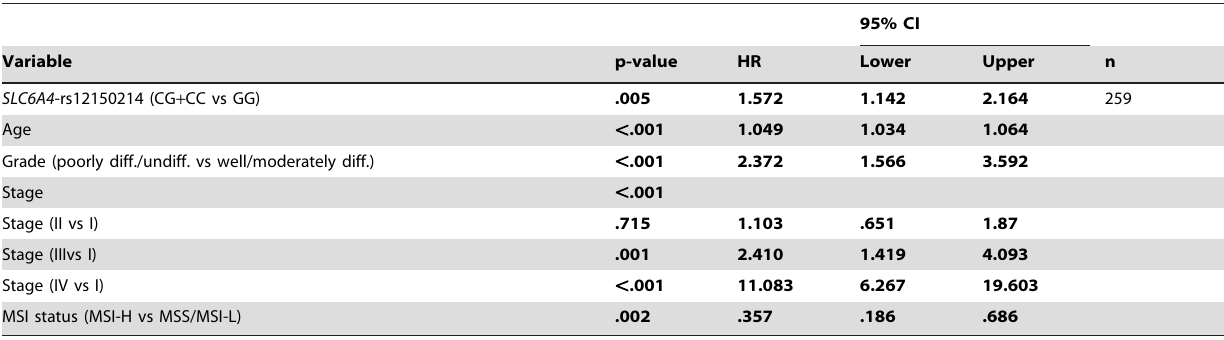
Table 4. Univariate analysis results for the combined genotypes of three SNPs within the SLC6A4 gene.